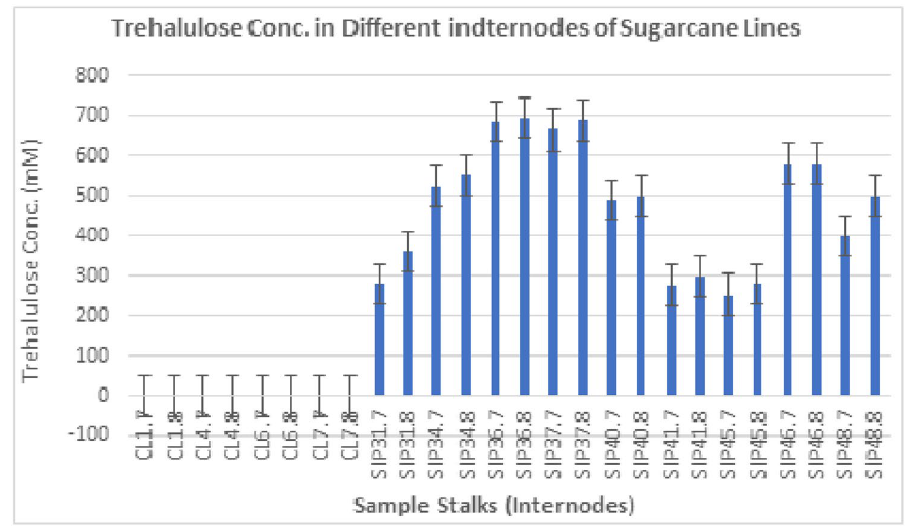
Figure 10. Graphical representations of TH contents quantified from HPLC based data from transgenic sugarcane lines contrasting to control